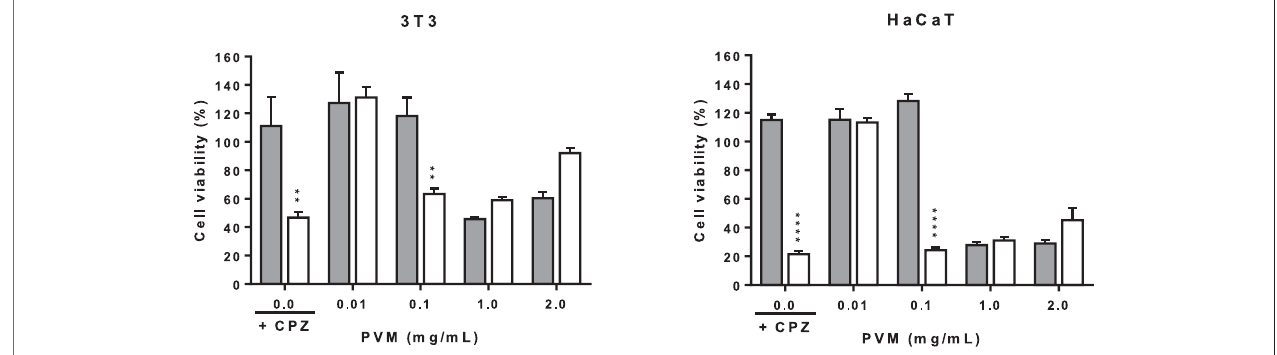
FIGURE 5 | Phototoxicity activityofPVM in3T3 and HaCaT celllines byMTT assay and expressed aspercentageofcellviability respect tothe correspondent control cells.Chloropromazinecellviabilitywasusedaspositivecontrol.GraycolumnscorrespondtocellsnonexposedtoUVAlightandwhitecolumnscorrespondtocellsexposed to 1.8 J/cm 2 of UVA light. Results are expressed as mean ± standard error of n (cid:2) 3. A two-way analysis of variance (ANOVA) and a Bonferroni post hoc assay have been performed. Statistical differences were considered as follows: ** p ≤ 0.01 and **** p ≤ 0.0001 compared with correspondence no irradiated/irradiated positive control.